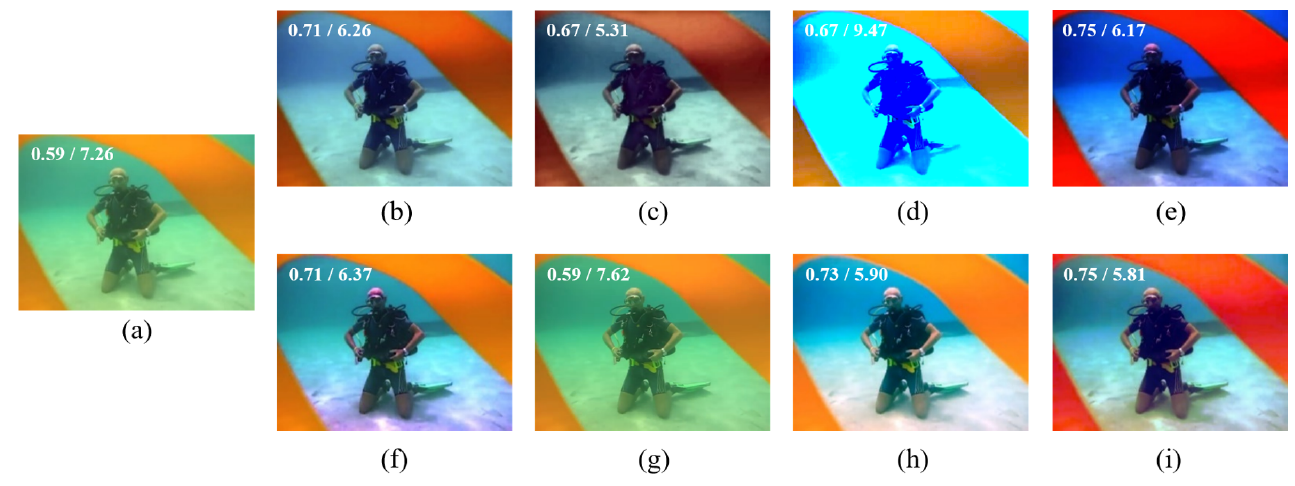
Figure 6. ( a ) Greenish underwater image with a diver and ribbons, and its restored/enhanced results obtained using ( b ) Fusion-based[43], ( c ) Retinex-based[44], ( d ) IBLA[10], ( e ) AGC[45], ( f ) GDCP[9], ( g ) UWCNN[26], ( h ) BL-TM[40], and ( i ) the proposed method. The number on the top-left corner of each image refers to its UCIQE/NIQE